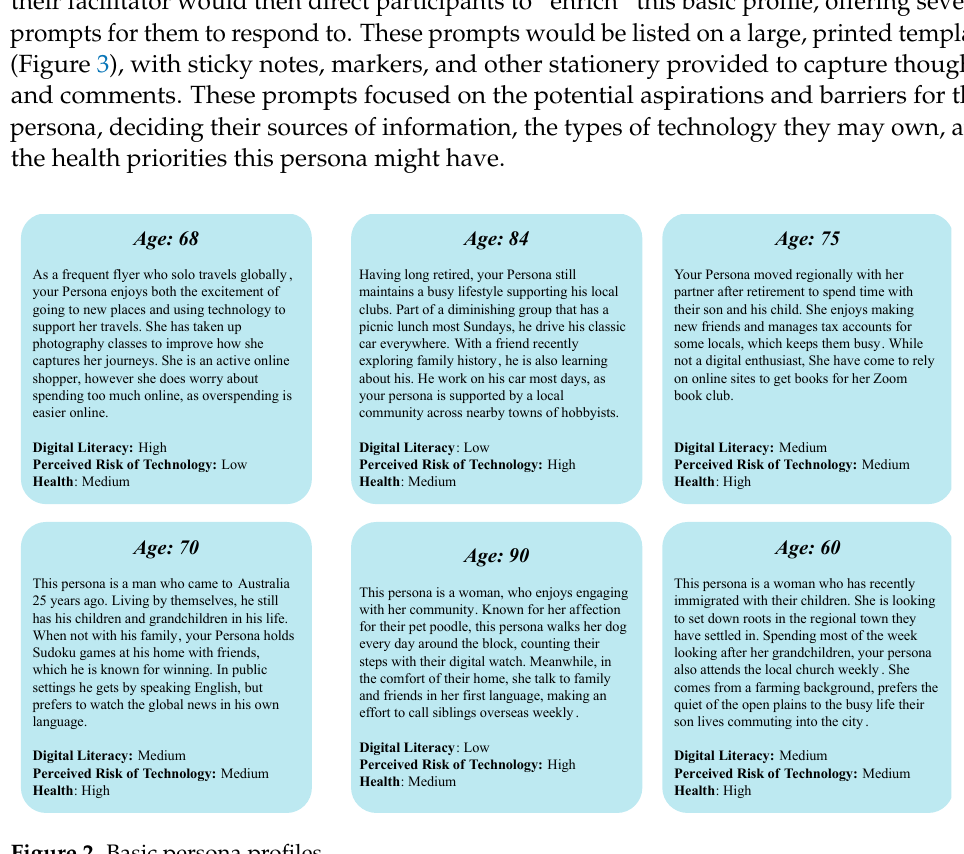
Figure 3. Persona enrichment template. 3.3. Scenario Mapping Activity Following the persona enrichment, the scenario mapping involved the same groups placing their persona into three different scenarios, mapping out the problems they might face and the solutions they might employ. Each of the scenarios was based around a